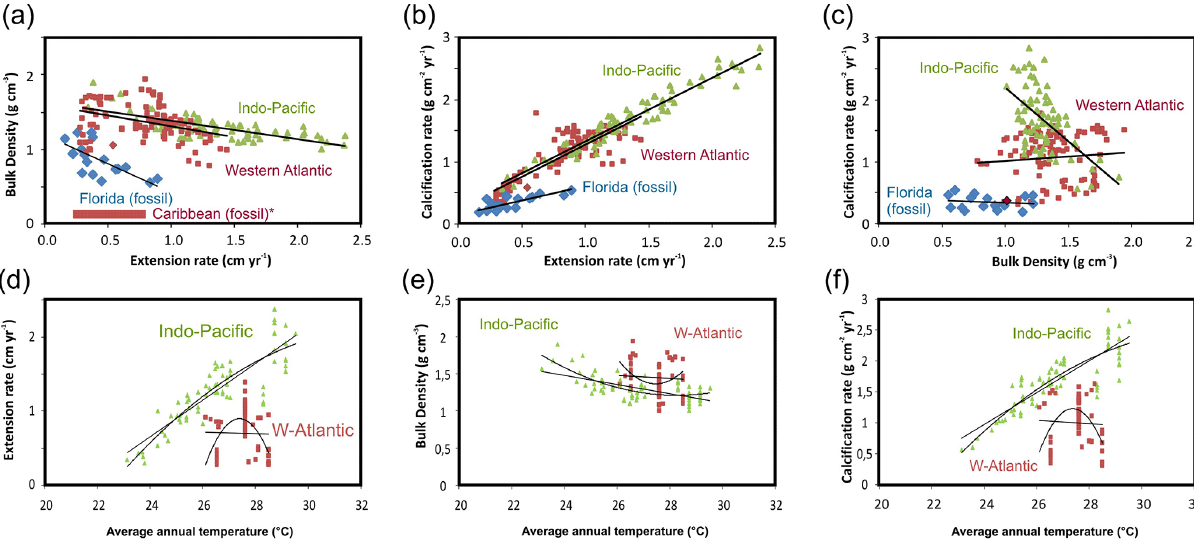
Figure 8. Extension rate, density and calcification rate of recent and fossil z corals. Indo-Pacific (green triangles), Western Atlantic (red squares) and Florida fossils (blue diamonds). (a–c) Descriptive diagrams for relationships of extension rate, density, and calcification rate within the temperature windows shown in (d–f) for modern corals. Recent corals compiled from literature (Carricart-Ganivet et al., 2000; Carricart-Ganivet and Merino, 2001; Dodge and Brass, 1984; Elizalde-Rendon et al., 2010; Highsmith et al., 1983; Hudson et al., 1989; Lough, 2008; Mallela and Perry, 2007; Tanzil et al., 2009). ∗ Red horizontal bar in Fig. 7a summarizes published extension rates of z corals of Pliocene age in the Caribbean region (various taxa) for comparison (Johnson and Pérez, 2006). (d–f) Extension rate, bulk density and cal- cification rates as a function of average annual temperature. Results of linear and quadratic polynomial regression are as follows: (a) West- ern Atlantic y = − 0 . 2958 ×+ 16072; R 2 = 0.1399, p <0.05. Indo-Pacific y = − 0 . 2499 ×+ 1 . 6358; R 2 = 0.5167, p <0.05. Florida